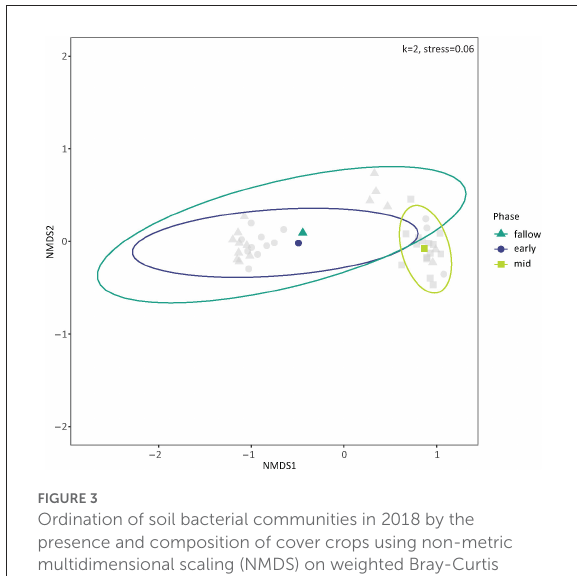
FIGURE3 Ordination of soil bacterial communities in 2018 by the presence and composition of cover crops using non-metric multidimensional scaling (NMDS) on weighted Bray-Curtis dissimilarities. The centroids and multivariate t-distribution ellipses for bacterial communities in the cover crop/fallow phase are designated by color and shape (circle for early season, triangle for fallow, and square for mid-season). For the NMDS calculation, k = 2, and stress = 0.06.